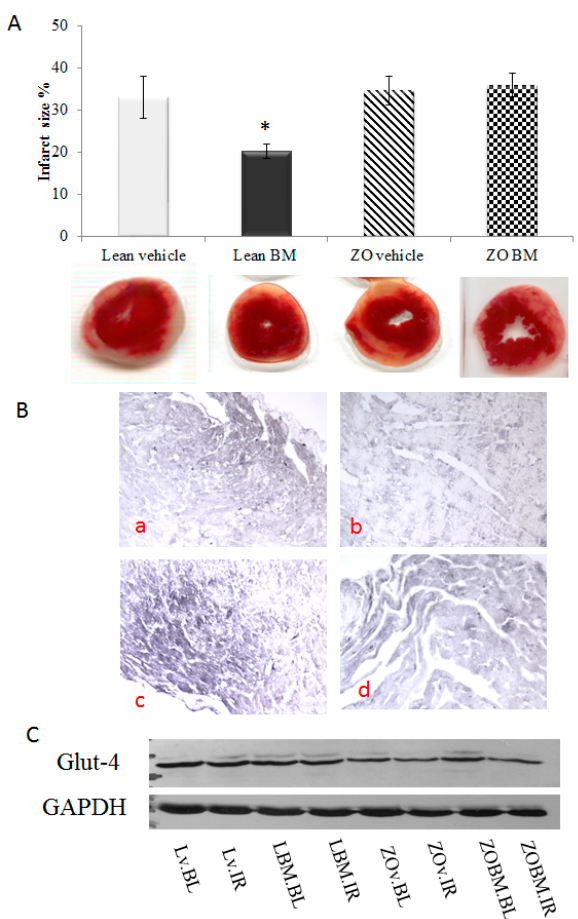
Figure 3. ( A ) Effect of bitter melon (BM) extract on postischemic cardiac infarct magnitude. Lean or Zucker Obese (ZO) rats ( n = 4 animals in each group), fed daily by gavage, for six weeks with mucin–water (vehicle), or BM extract of 400 mg/kg body weight, are sacrificed and thoracotomized, followed by mounting on isolated working heart apparatus. Hearts were subjected to 30 min of ischemia and 2 h of reperfusion, followed by perfusion with 35 mL of 1% TTC solution via aortic cannula and stored for 24 h at − 20 ◦ C to allow cardiac tissue solidification. Next, 2–3 mm-thick sections of stained hearts were scanned, weighed planimetrically analyzed and infarct size were calculated. Outcomes were expressed as the ratio of the total infarcted tissue volume to volume of at-risk tissue ± SEM. Significance level of difference ( p ) between average outcome values shown in histograms, is p < 0.05, or less, indicated as follows: * p < 0.05 versus Lean IR values; ( B ) Effect of BM extract on postischemic expression of caspase-3 in isolated, ischemia/reperfusion (I/R)-injured rat hearts. Lean or Zucker Obese (ZO) rats ( n = 4 animals in each group), fed daily by gavage, for six weeks with mucin–water vehicle, or BM extract of 400 mg/kg body weight, are sacrificed and thoracotomized, followed by mounting on isolated working hearts in a Langendorff apparatus. Hearts were subjected to 30 min of ischemia and 2 h of reperfusion, followed by formalin fixation and paraffinization. Then, 4.5 micron thick sections were subjected to immunohistochemical analyses for caspase-3. Images shown include: Lean rats treated with vehicle ( Ba ); Lean rats administered BM extract ( Bb ); ZO rats receiving vehicle ( Bc ); and ZO rats receiving BM extract ( Bd ); ( C ) Effect of Bitter melon (BM) extract on Glut-4 expression: Protein samples from hearts originated from Lean and ZO animals in the presence or absence of BM treatment were separated and probed with Glut-4 antibody. As it is depicted, the level of Glut-4 is lower in samples from ZO animals regardless of treatment. However, the BM treatment failed to alter the cardiac Glut-4